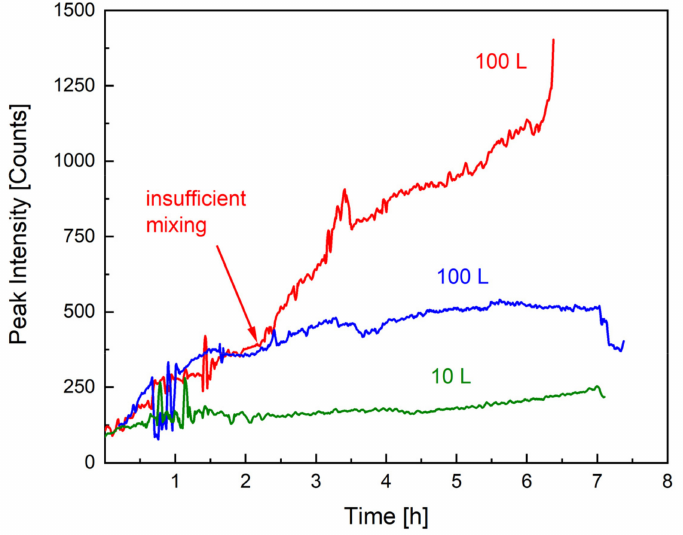
Figure 3. Monomer concentration over time, tracked by Raman spectroscopy (1646 cm − 1 ). The green and blue trends show the course of the Raman peak throughout an emulsion polymerisation in, respec- tively, 10 and 100 L. The red line describes the monomer accumulation when mixing is